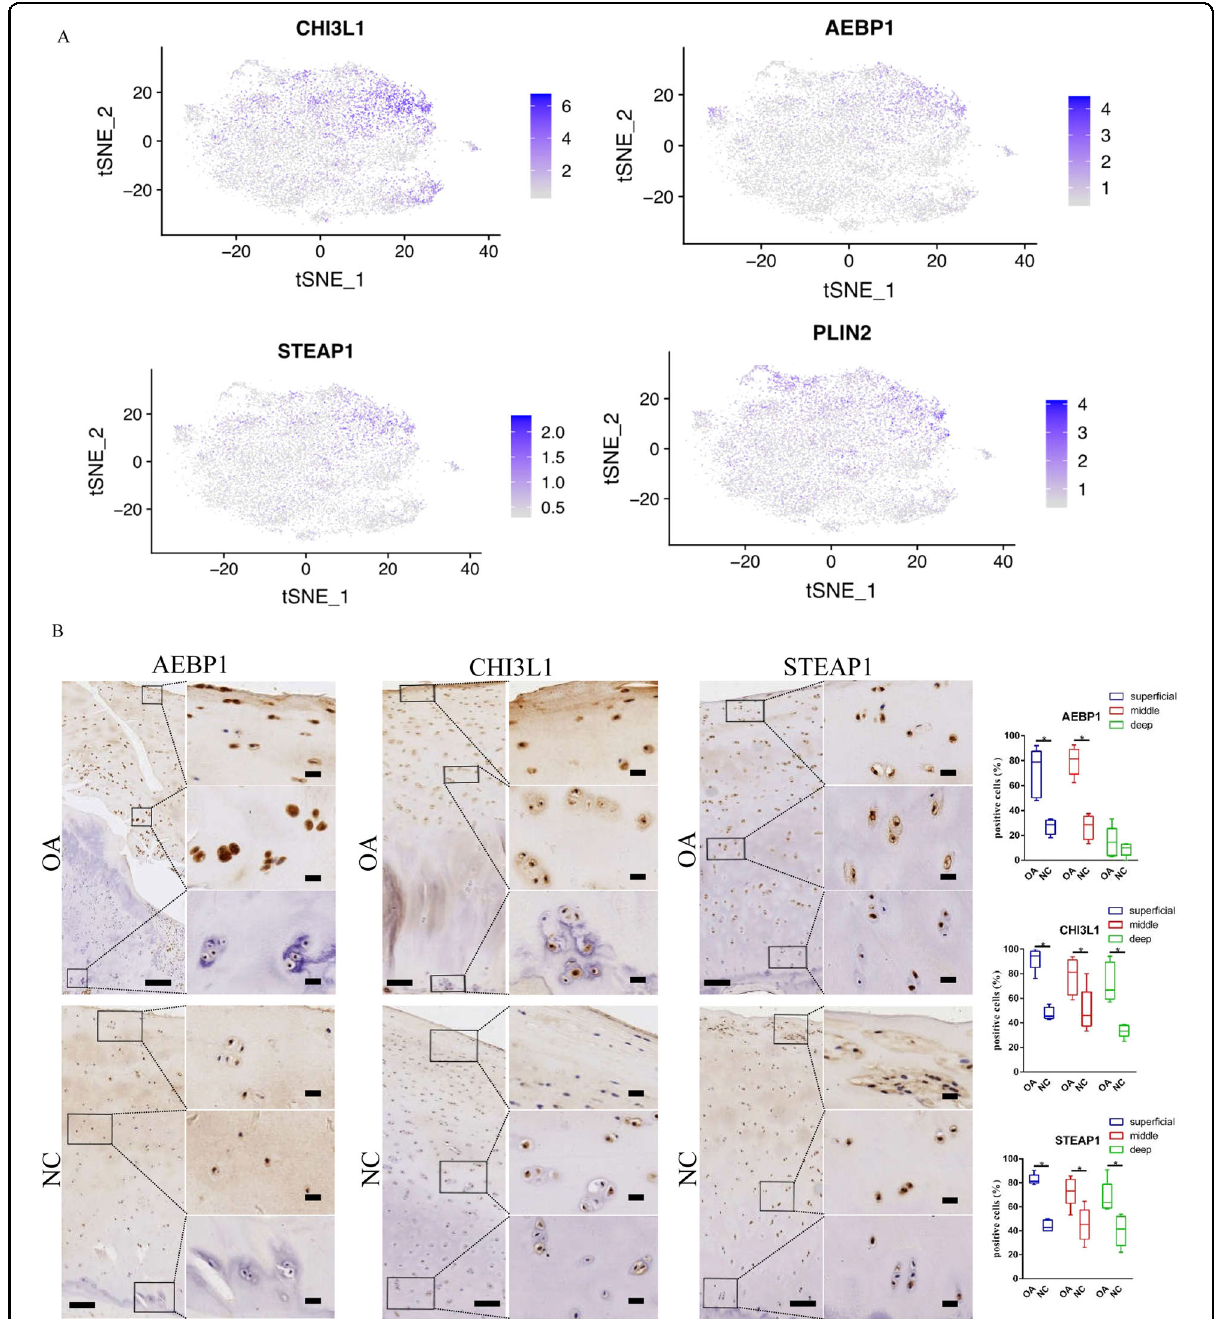
Fig. 3 Single-cell RNA-sequencing analysis of the cell population in OA. A Gene expression plots of CHI3L1, AEBP1, STEAP1 and PLIN2. Dot colour corresponds to the level of gene expression in each cell. t-SNE, t-distributed stochastic neighbour embedding. B Representative immunohistochemistry staining of AEBP1, CHI3L1 and STEAP1 in OA and healthy cartilage tissues. Scale bar, left, 500 μ m; right, 50 μ m, and comparative quanti fi cation of positive cells of different areas (super fi cial, middle, deep) between OA and healthy cartilage tissues displayed by box plot ( n = 5). * p <